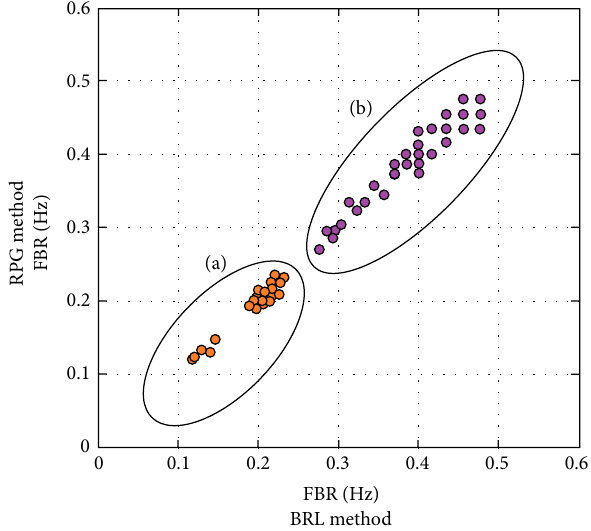
Figure 4: Correlation field of FBR calculated for BRL and RPG signals ((a): spontaneous breathing; (b): rapid breathing).